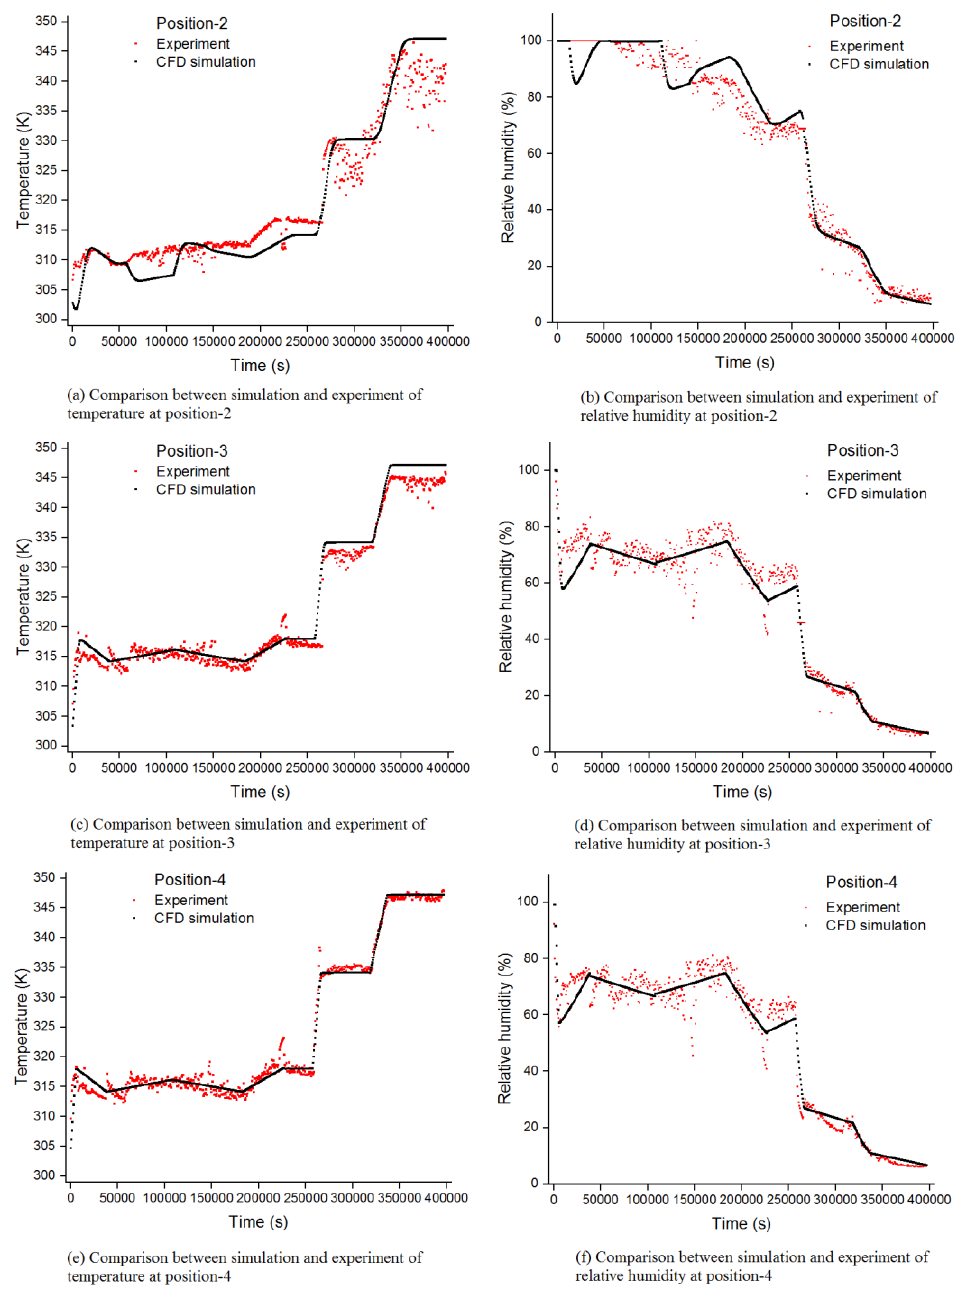
Figure 8. Comparison between CFD simulation and experiment of the temperature and relative humidity at position-2, position-3 and position-4.